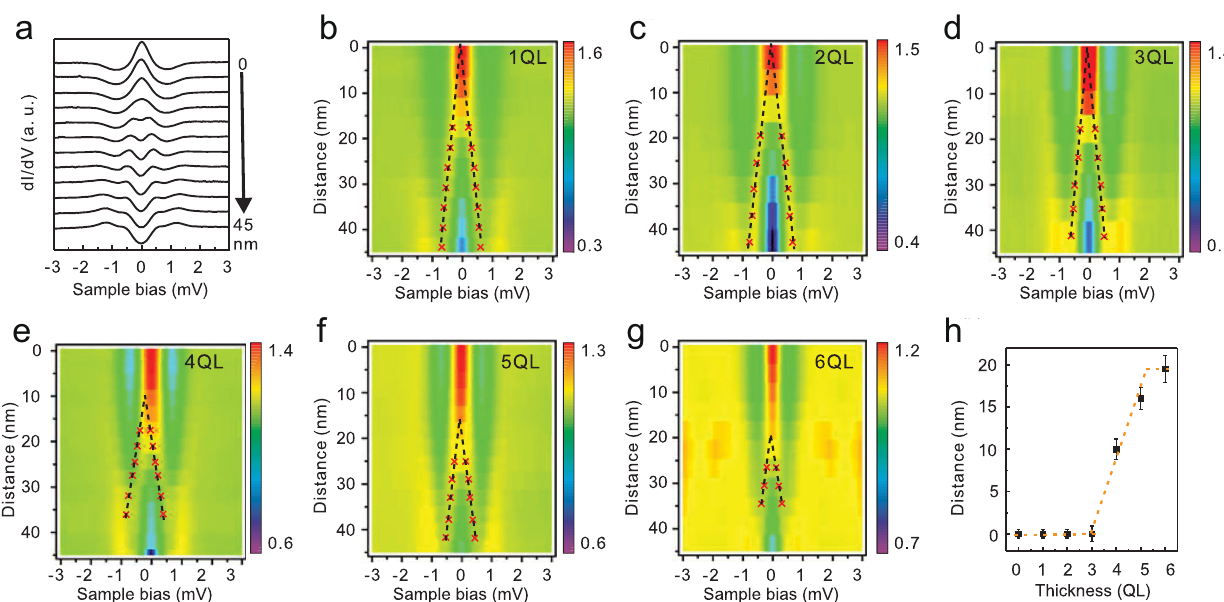
Fig. 6 a A series of STS spectra curves measured along the line starting from the core to the edge of the vortex, showing the peak of bound states splits into two at positions away from the vortex center. b The color image of a for a better view. The split peak positions in the STS spectra are marked by red crosses , and the dotted lines superimposed on the crosses indicate the start point of the peak splitting. c – g The experimental results for 2 – 6 QL samples, following the similar data process of ( b ). h A summary of the start points of the peak split, showing a crossover at 4 QL. a – h reprinted with permission from ref. 16, copyright 2015 by the American Physical